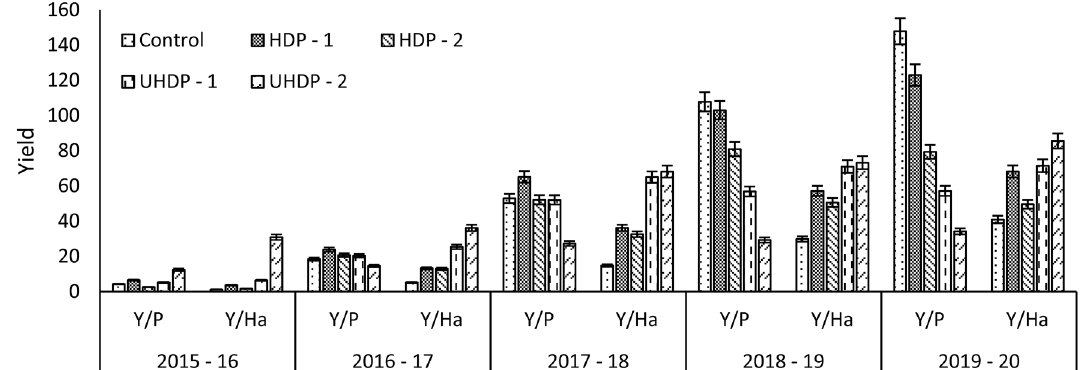
Figure 4. Effect of planting density on fruit yield in terms of per plant and per hectare. Control: Planting at 6 m (row to row) × 6 m (plant to plant) spacing (tree density—277 plants ha −1 ), HDP-1: Planting at 6 m (row to row) × 3 m (plant to plant) spacing (tree density—555 plants ha −1 ), HDP-2: Planting at 4 m (row to row) × 4 m (plant to plant) spacing (tree density—625 plants ha −1 ), UHDP-1: Planting at 4 m (row to row) × 2 m (plant to plant) spacing (tree density—1250 plants ha −1 ), UHDP-2: Planting at 2 m (row to row) × 2 m (plant to plant) spacing (tree density—2500 plants ha −1 ); Y/P: yield plant −1 (kg plant −1 ), Y/Ha: yield hectare −1 (tons hectare −1